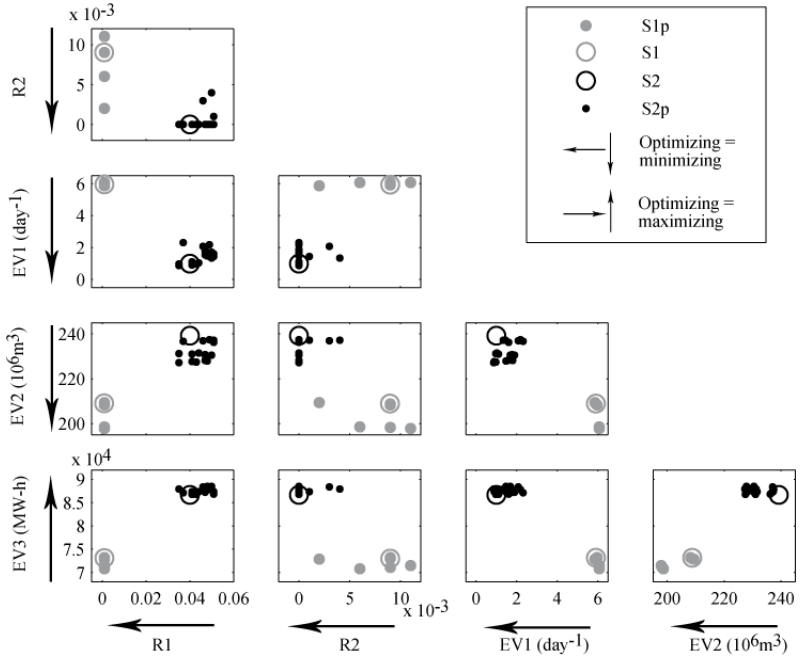
Figure 9. Depiction of the behavior of the strategies S1, S2, S1p and S2p in a scatter plot